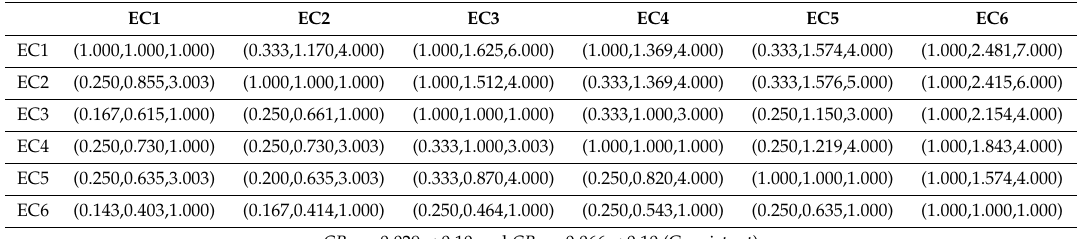
Table A7. Fuzzy pairwise comparison matrix with respect to the economic (EC) sub-criteria.